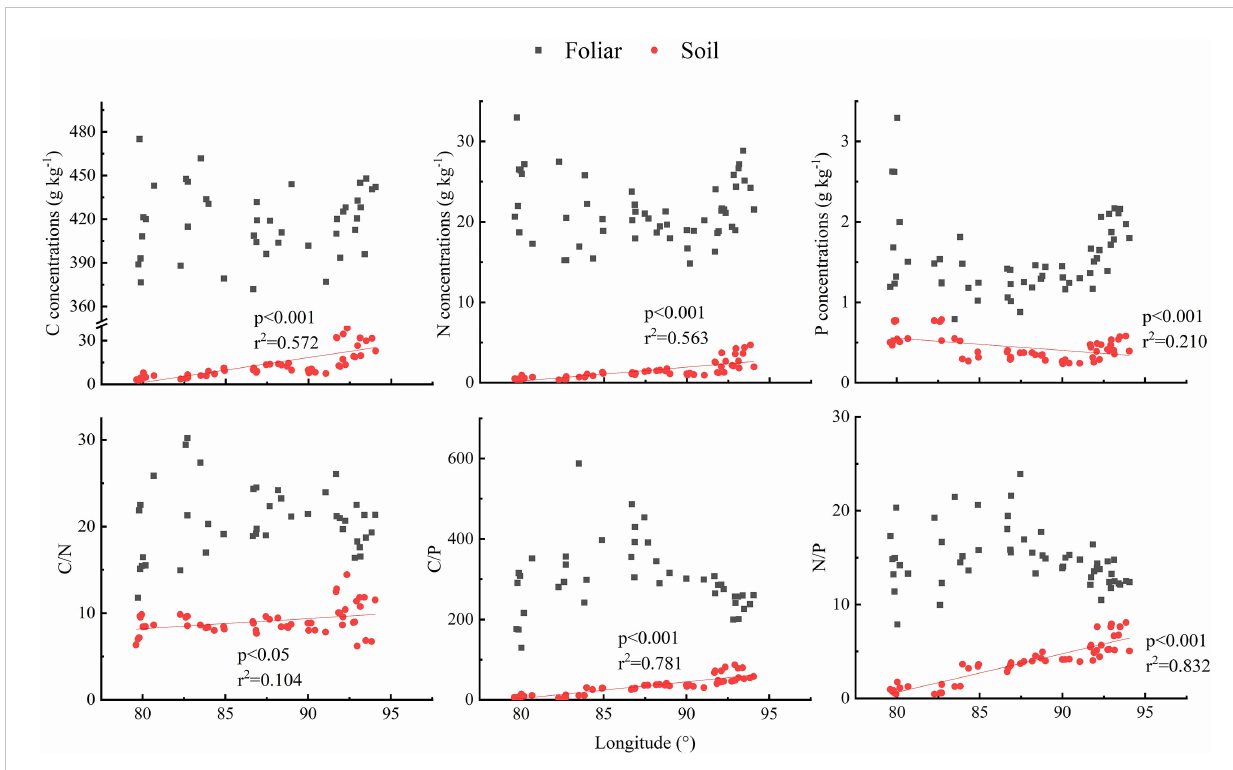
FIGURE 5 Longitude pattern of foliar and soil C, N, and P stoichiometry across north Tibet